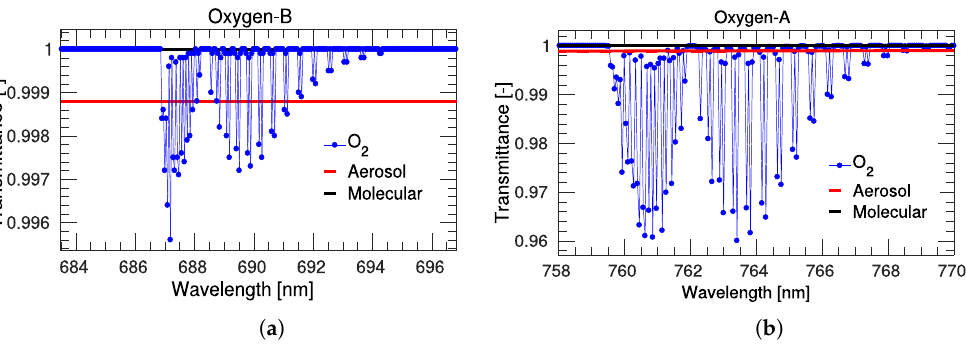
Figure 2. Simulated upward atmospheric transmittance from a 0 m surface elevation to a tower sensor at 10 m height, with nadir viewing geometry and sea–level pressure conditions. Transmittance has been simulated at 1 cm − 1 spectral resolution for the O 2 –B ( a ), i.e., ∼ 0.05 nm, and the O 2 –A ( b ), i.e., ∼ 0.06 nm, absorption regions. Note the different Y–axis ranges used to emphasize details in both O and O 2 –A